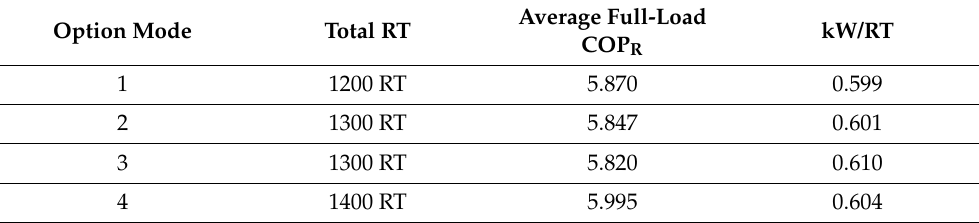
Table 11. Case study analysis 2